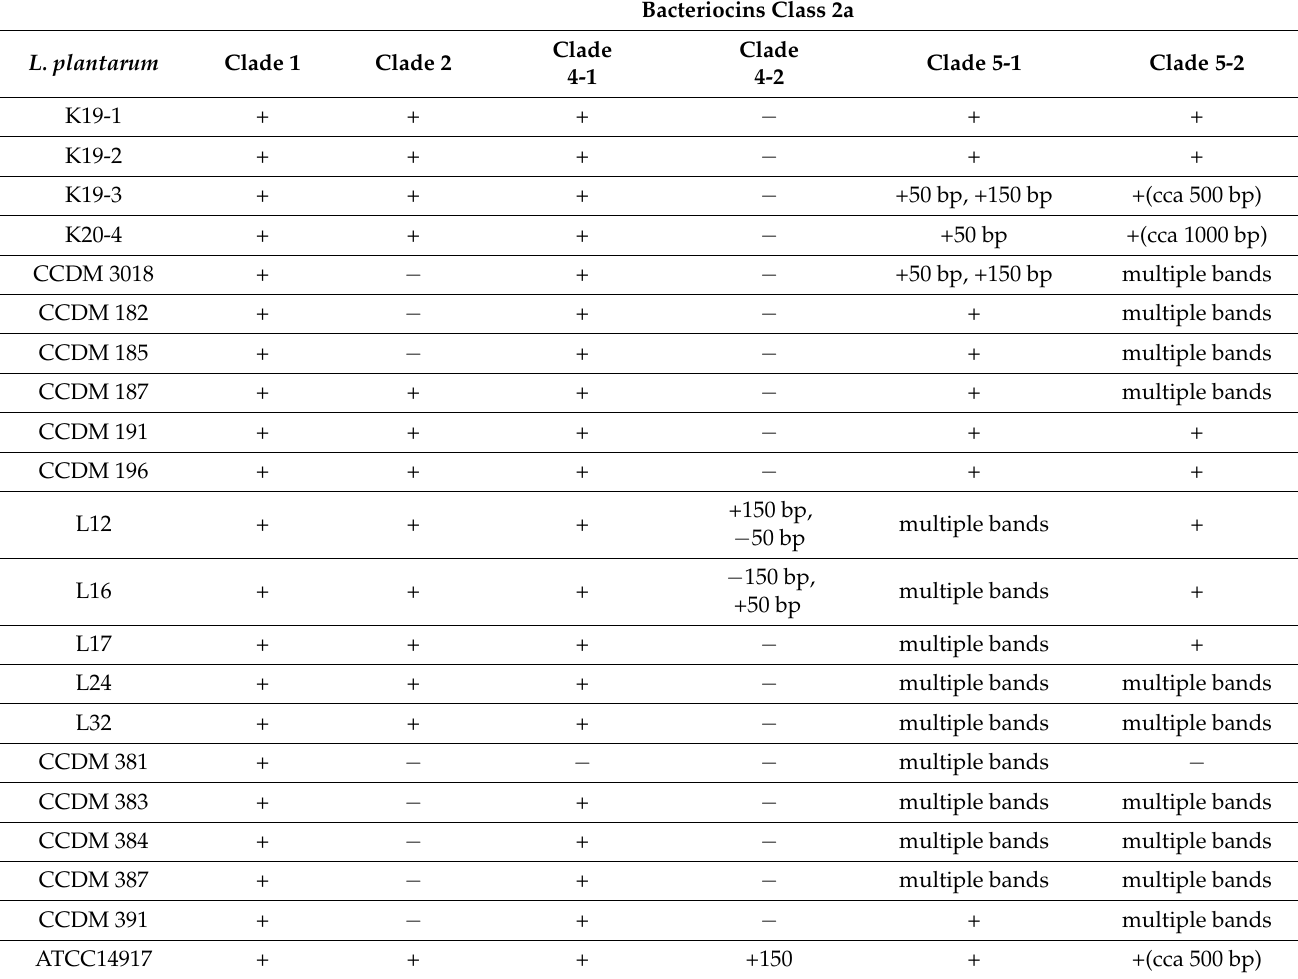
Table 5. The presence of bacteriocin Class 2a genes in cell-free filtrate with 30.000 NMWL. Bacteriocins Class 2a L. plantarum Clade